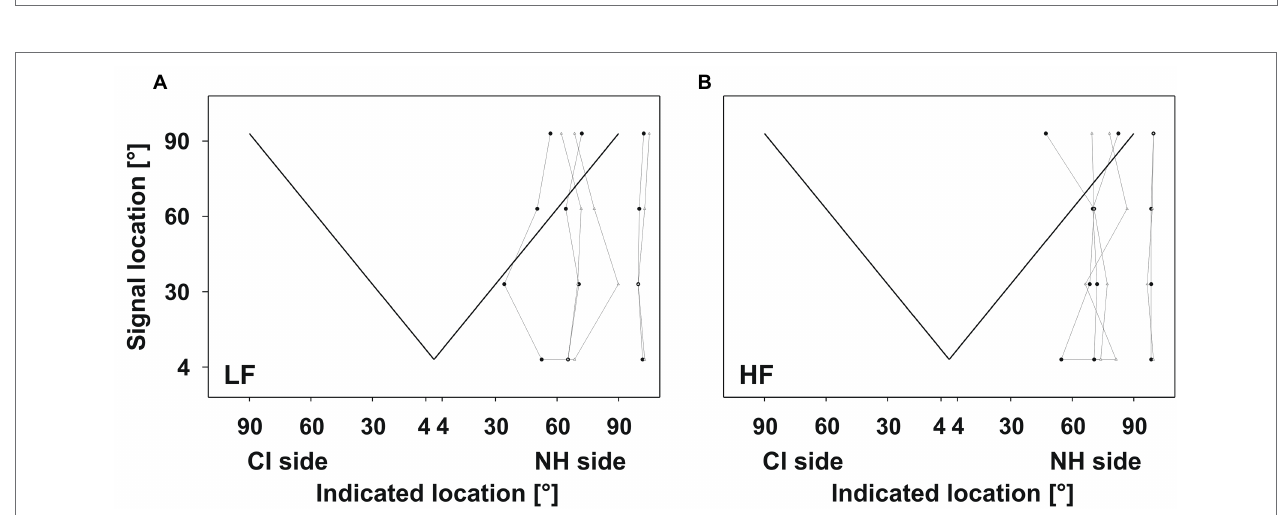
FIGURE 4 | Poor performers. Layout of the plots as in Figure 3 . Participants did not benefit from their CI for localization; all responses indicated the NH side irrespective of signal